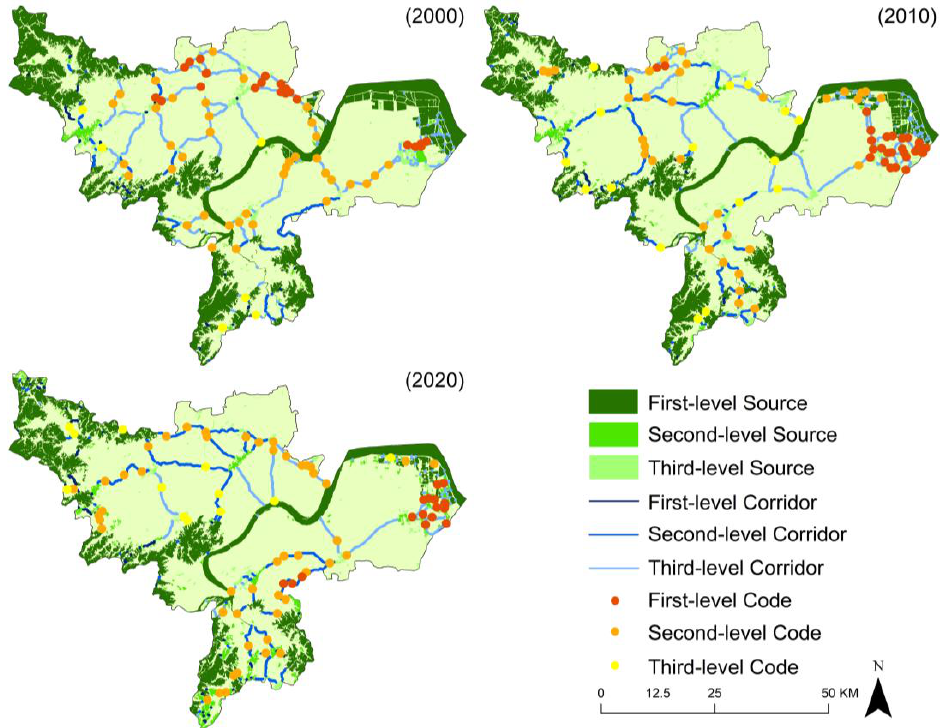
Figure 8. GI networks ’ spatial priority distribution at all levels in 2000, 2010, and 2020.